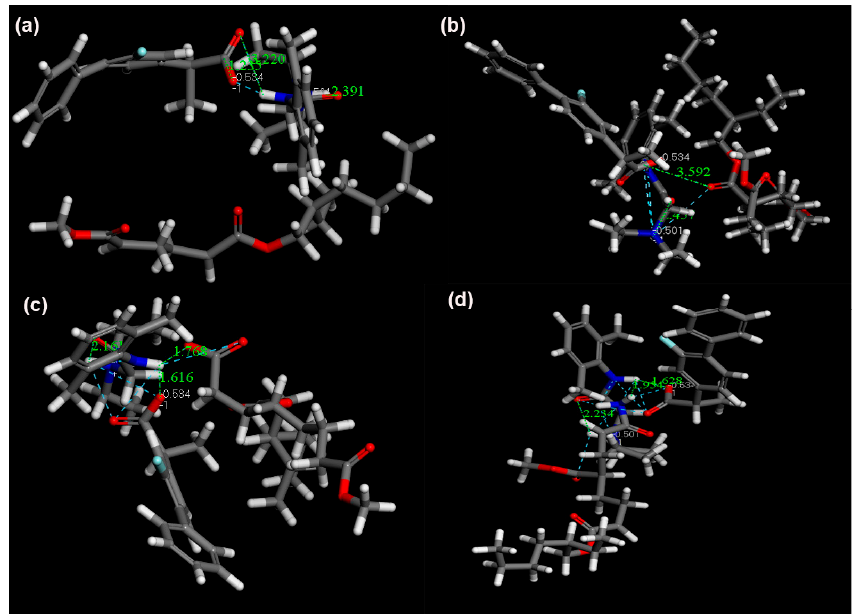
Figure 10. Optimal conformations of ILs with ( a ) PSA − none, ( b ) PSA − OH, ( c ) PSA − COOH, and ( d ) PSA − CONH 2 .